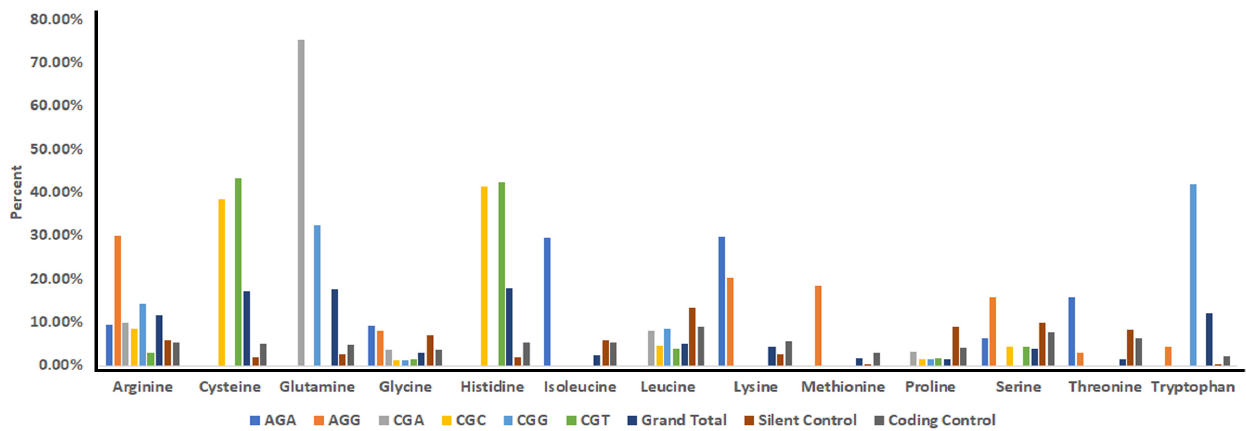
Figure 3. Observed distribution of nucleotide changes and amino acid substitutions in human cancers from the six arginine codons. We re-analyzed the COSMIC data (version 94) to determine the contribution of each arginine codon to arginine amino acid substitutions. The graph is a composite showing both the amino acid substitutions and the base pair changes resulting in those substitutions. Included as controls are the COSMIC frequency of changes that result in silent mutations, those that result in amino acid substitutions on the non-coding strand, and any change occurring in untranscribed regions, as reported on COSMIC. “Grand total” represents the percentages of nucleotide changes present in arginine mutations regardless of the starting or mutated codon.